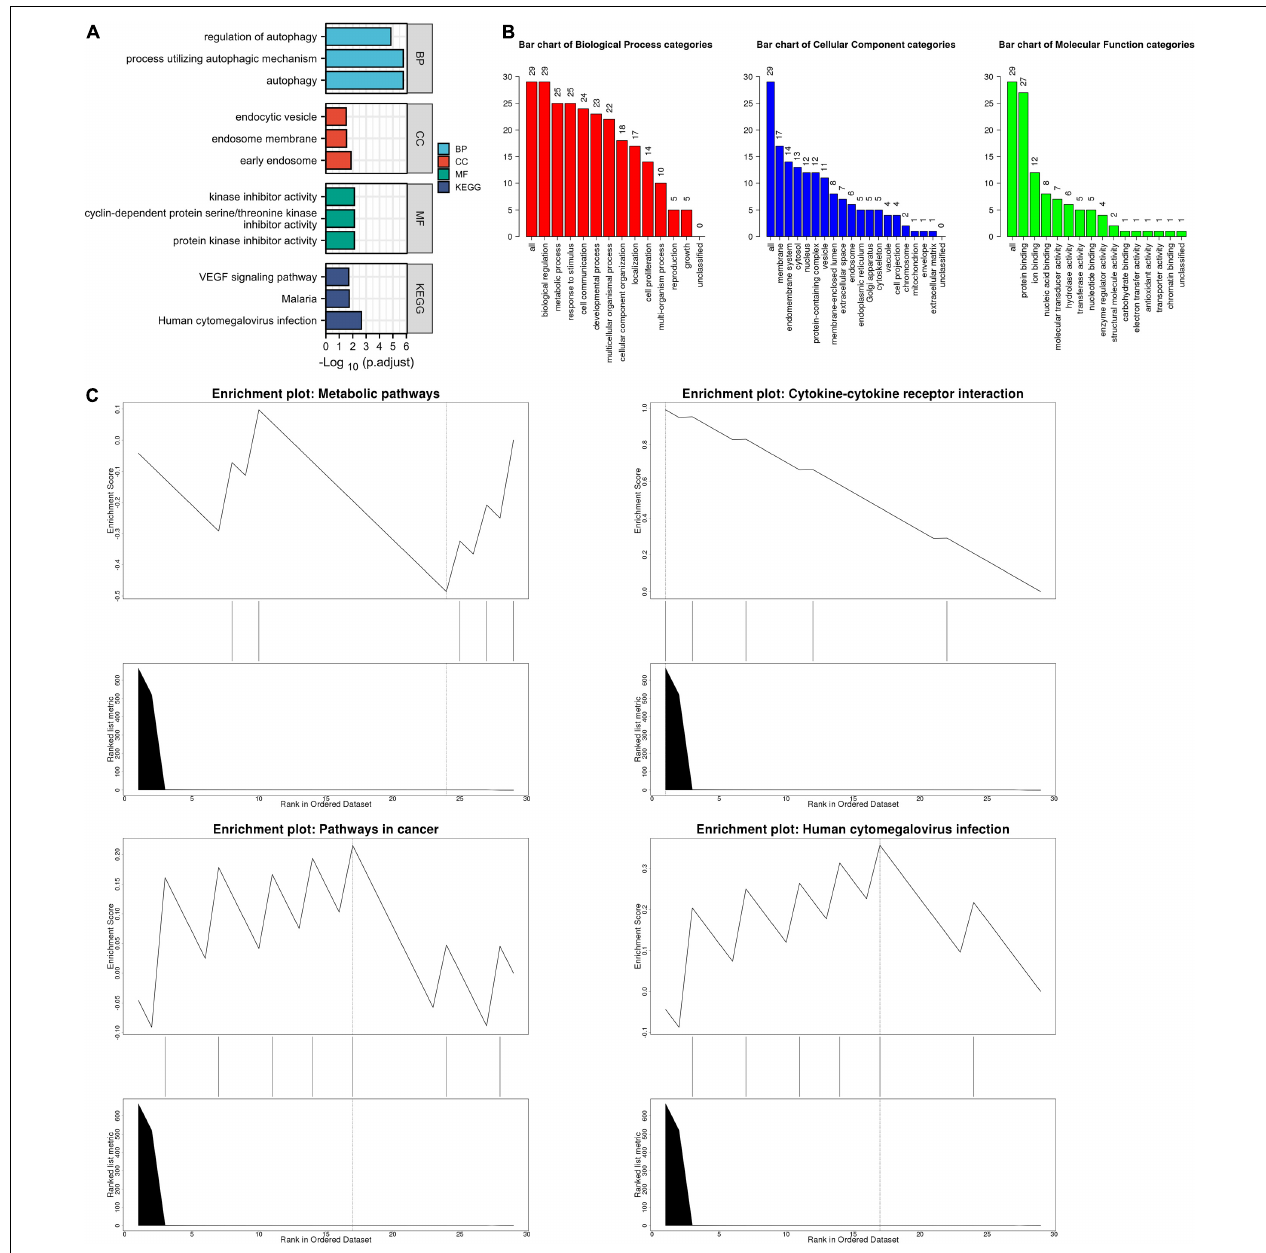
FIGURE 4 | The enrichment pathway analysis of autophagy-related DEGs. (A) The significant GO and KEGG pathways enriched by autophagy-related DEGs using the Xiantao Website. (B) The GO enrichment pathway analysis of autophagy-related DEGs using WebGestalt. (C) The Gene Set Enrichment Analysis of autophagy-related DEGs using